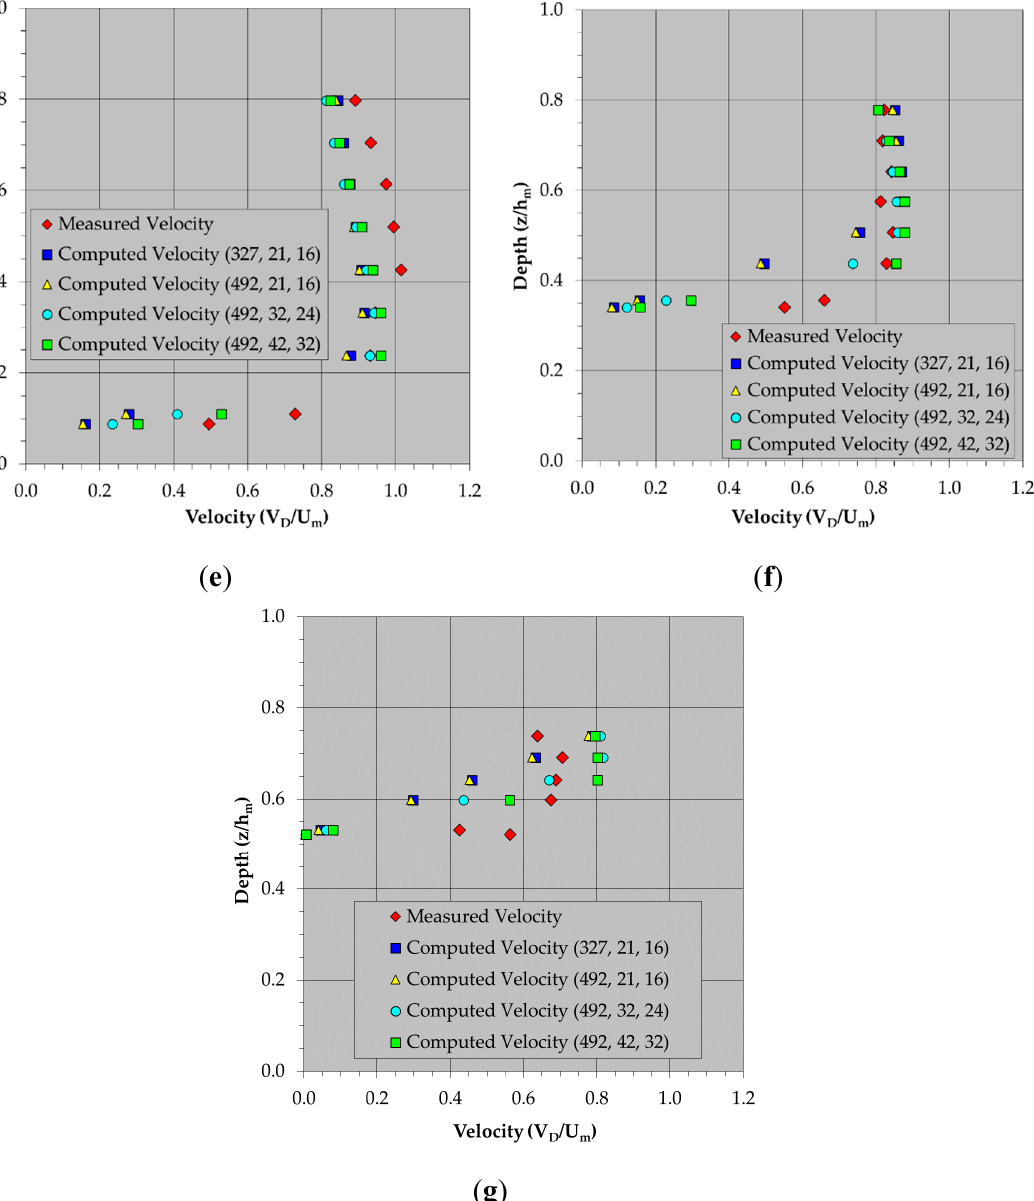
Figure A14. Comparisons of simulated and measured stream-wise velocity profiles using four different mesh sizes at Cross-section 6, located in the upstream channel curve (profile measurement locations “ a ”–“ g ” are positioned left to right looking downstream).